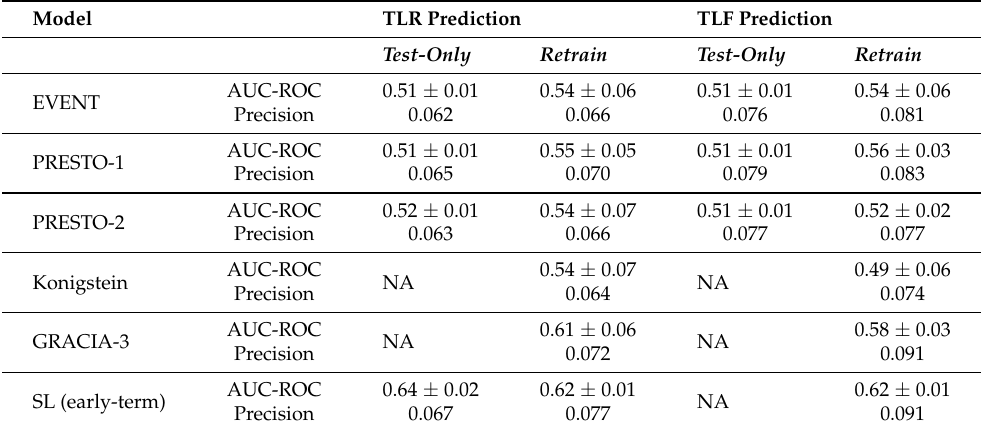
Table 6. Comparison of performance between our model (SL early-term), and five of the state of the art models. Reported values are AUC-ROC and their standard deviation, as well as precision score for the model when it was set to achieve 90% sensitivity. NA means models do not